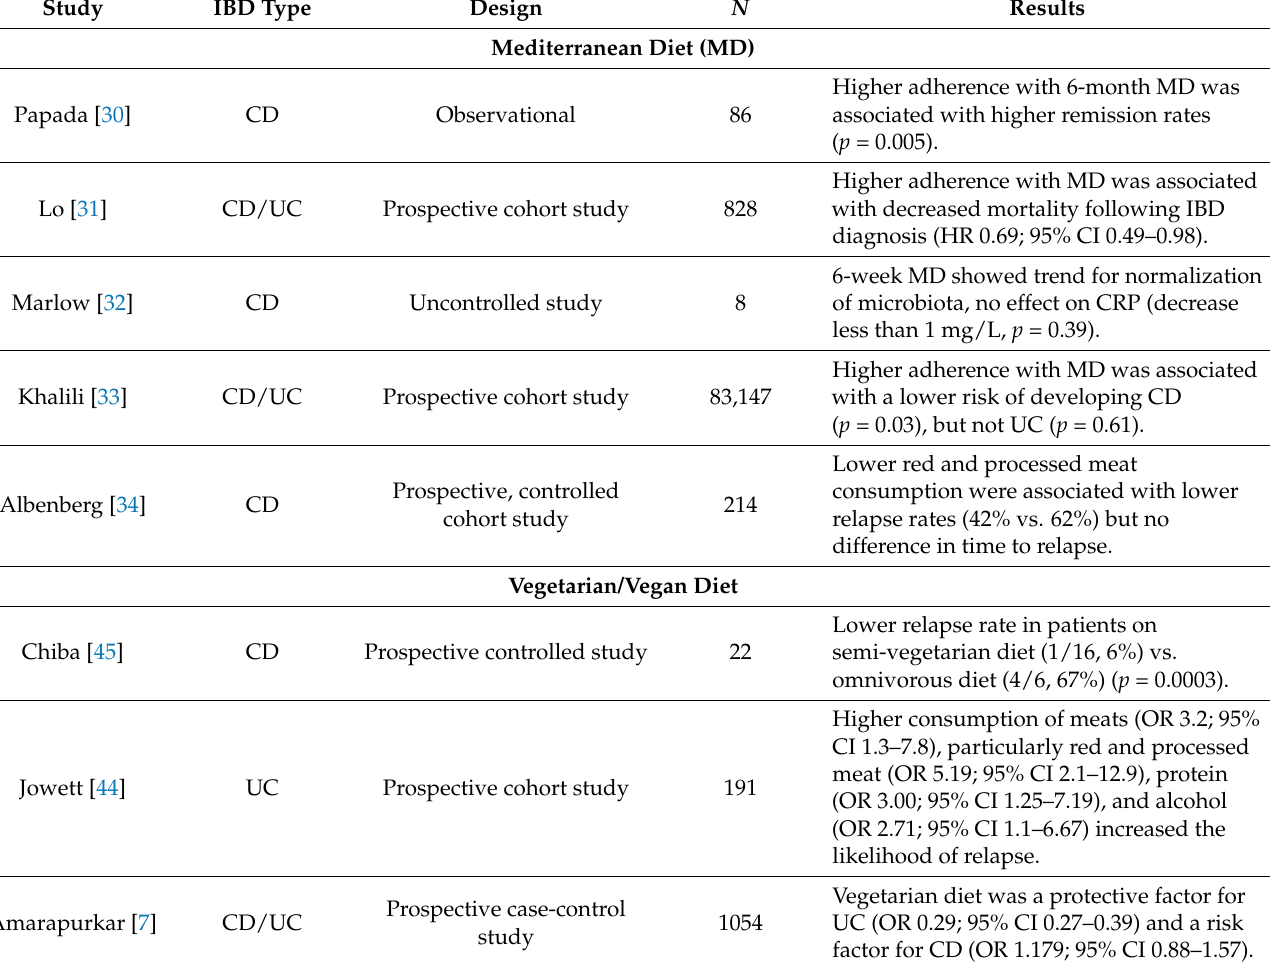
Table 4. Summary of dietary clinical trials in IBD. Current data suggest that lower meat consumption may avoid relapse, and low fermentable oligosaccharides, disaccharides, monosaccharides, and polyols (FODMAP) can provide relief from functional-like gastrointestinal